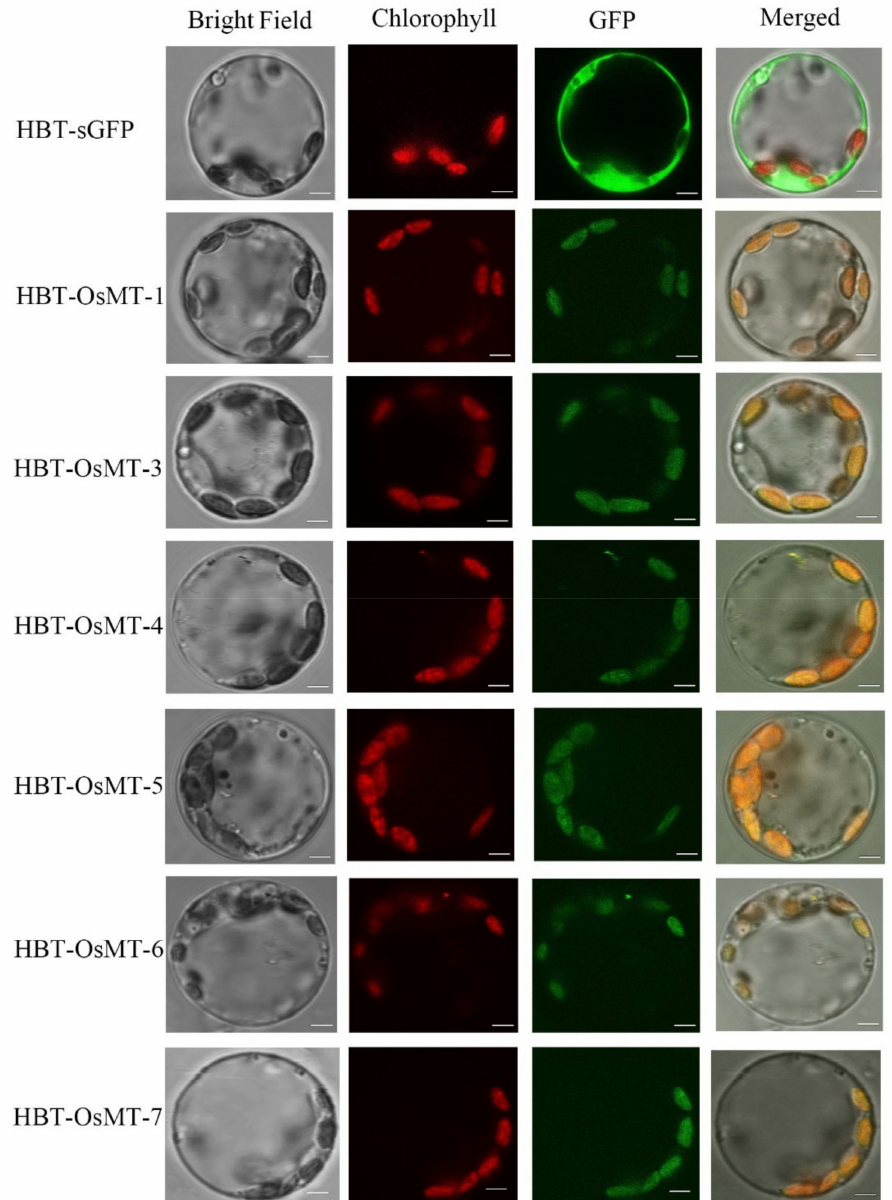
Figure 8. Subcellular localization of OsMT proteins in rice green seedling protoplasts. The empty vector, HBT-sGFP, was used as a control. Bright-field images (Bright Field), chlorophyll autofluores- cence (Chlorophyll), fluorescence of eGFP fusion protein (GFP), and merged images (Merged) were examined using laser scanning confocal microscopy. Bars = 3 µ